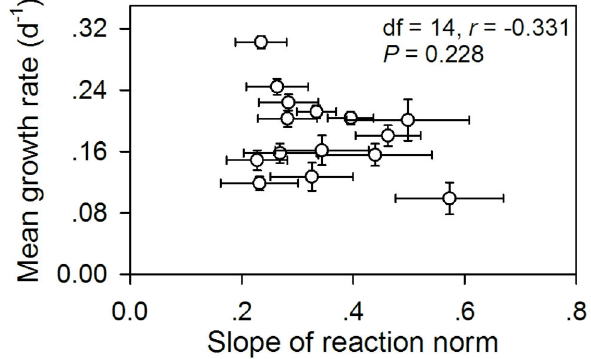
Figure 6. Slopes of reaction norms for 15 sympatric Bosmina longirostris clones versus the mean growth rates when feeding on the “good” and “poor”